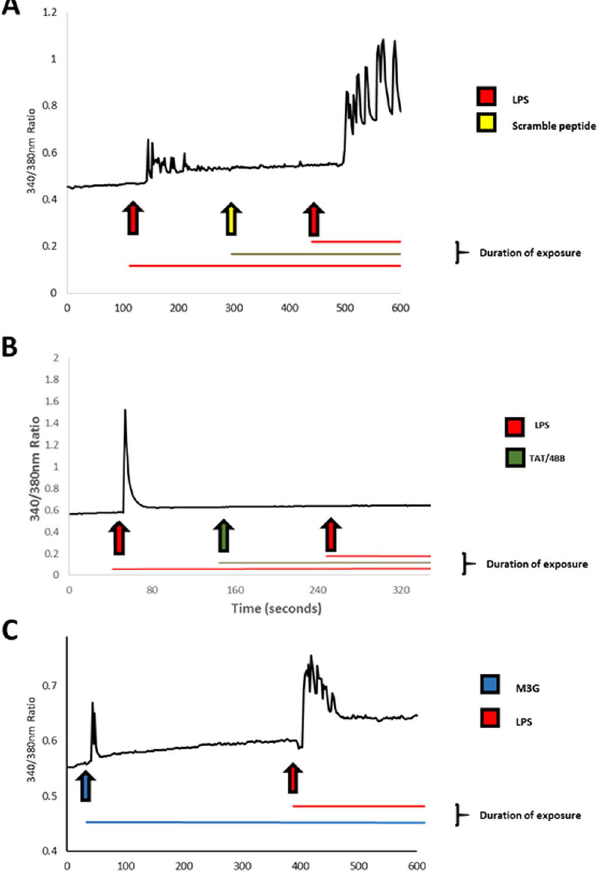
Figure 3. Lipopolysaccharide (LPS) and morphine-3-glucuronide (M3G) increases in calcium signaling in cultured dorsal root ganglion (DRG) neurons can be prevented by exposure to TAT-4BB. Ca 2 + imaging was performed on acutely dissociated adult sensory neurons using the ratiometric Ca 2 + - sensitive dye, FURA-2AM. ( A ) Selected trace depicts neuron response to LPS followed by wash out of the well with room-temperature bath solution. Cells were then exposed to control scramble peptide followed by LPS exposure. Control peptide did not alter LPS-induced event. ( B ) Selected trace depicts neuron response to LPS followed by wash out of the well with room-temperature bath solution. Cells were then exposed to TAT-4BB peptide followed by LPS exposure. Second LPS exposure failed to elicit change in Ca 2 + -flux. ( C ) Selected trace depicts neuron response to M3G followed by wash out with bath solution. Cells were then exposed to LPS which elicited a second Ca 2 +